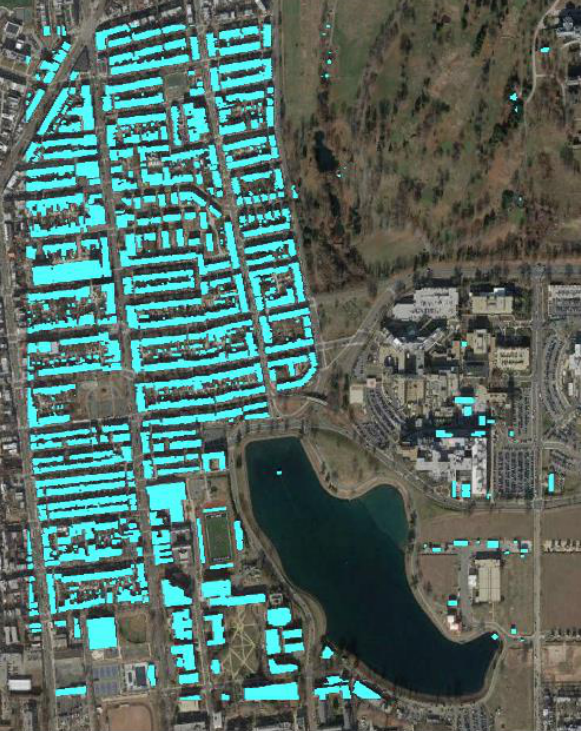
Figure 3. Builds extracted from Open Street Map and the comparison with Google